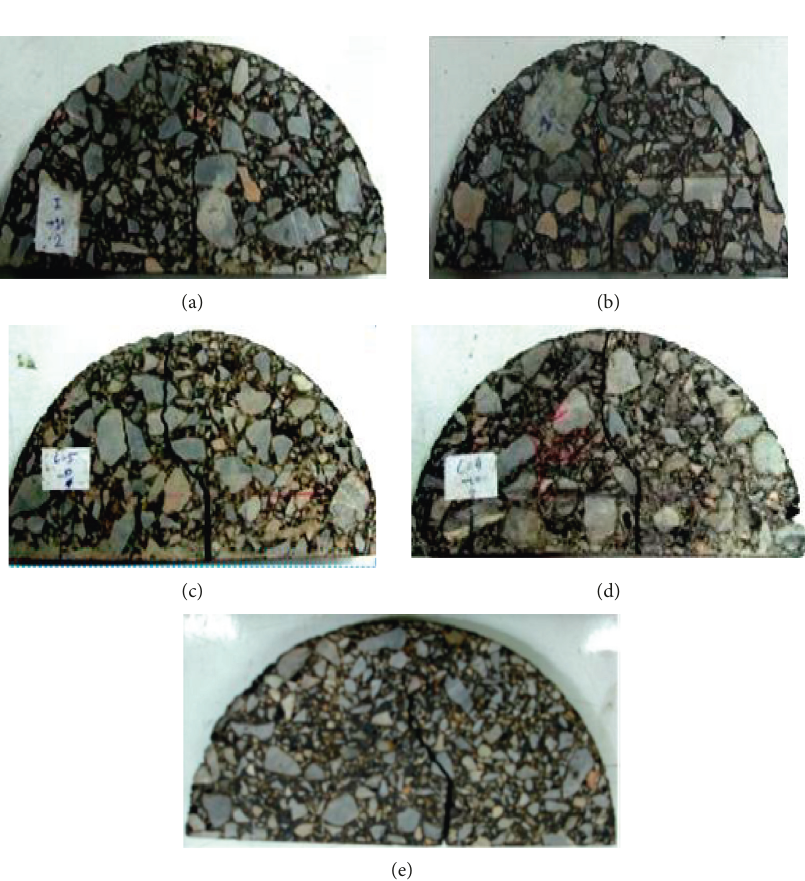
Figure 3: Crack routes at different loading modes. (a) M